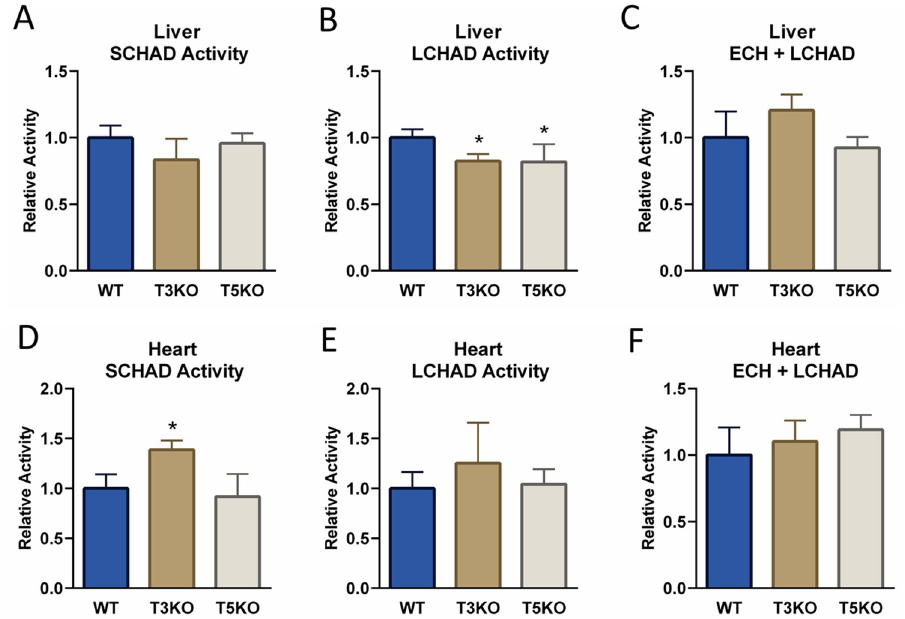
Fig 3. SCHAD and TFP enzyme activities in Sirt3KO and Sirt5KO mouse liver and heart mitochondria. Mitochondria were isolated from N = 5 wild-type (WT), Sirt3KO (T3KO), and Sirt5KO (T5KO) mouse livers and hearts and assayed in the reverse direction for SCHAD activity with acetoacetyl-CoA (panels A and D), in the reverse direction for isolated LCHAD activity with keto-C 16 -CoA (panels B and E), and in the forward direction with channeling of enoyl-C 16 -CoA through the combined ECH and LCHAD activities of TFP α (panels C and F). � P < 0.05 versus wild-type. All bars represent means and standard deviations.